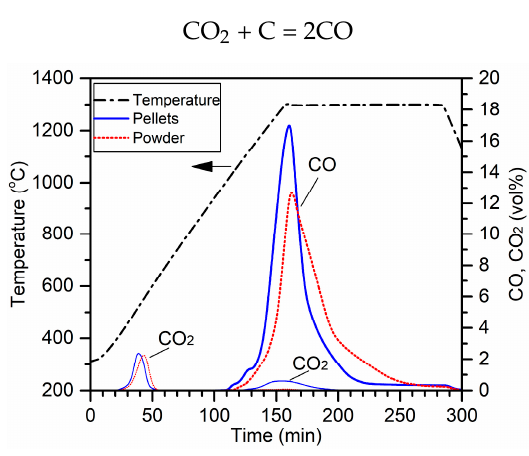
Figure 14. Temperature profiles, off-gas CO and CO 2 concentrations for the tests using pellet and powder samples.